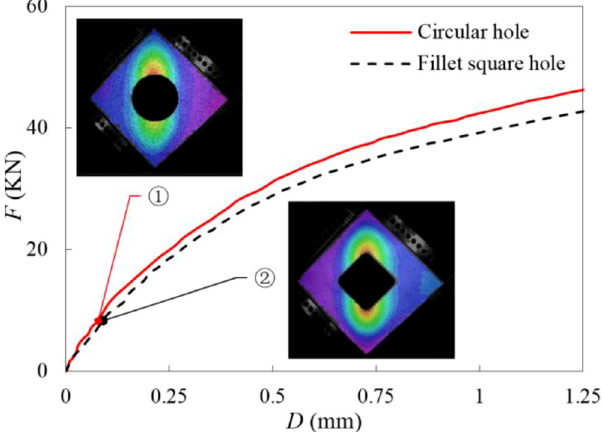
Fig. 6. Force versus displacement of plates with different hole.